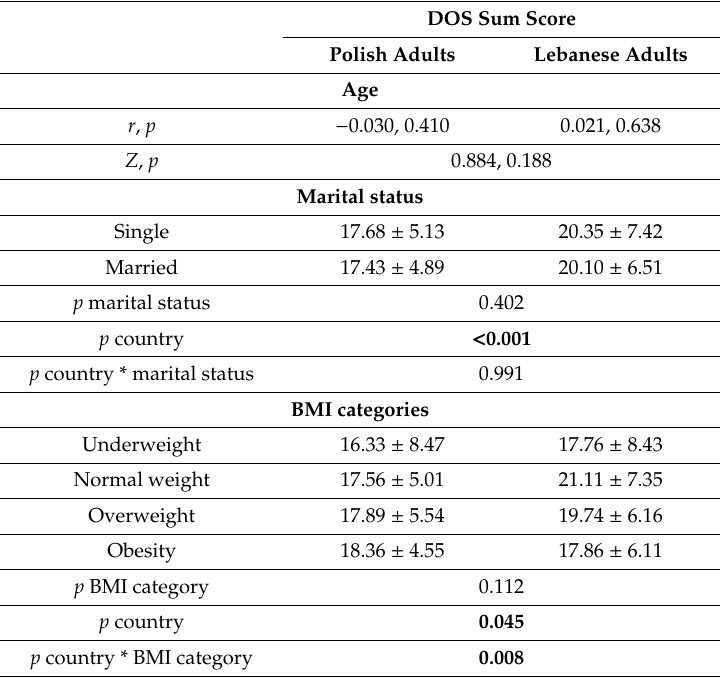
Table 7. Relation between ON and sociodemographic variables and BMI ranges in Polish and Lebanese